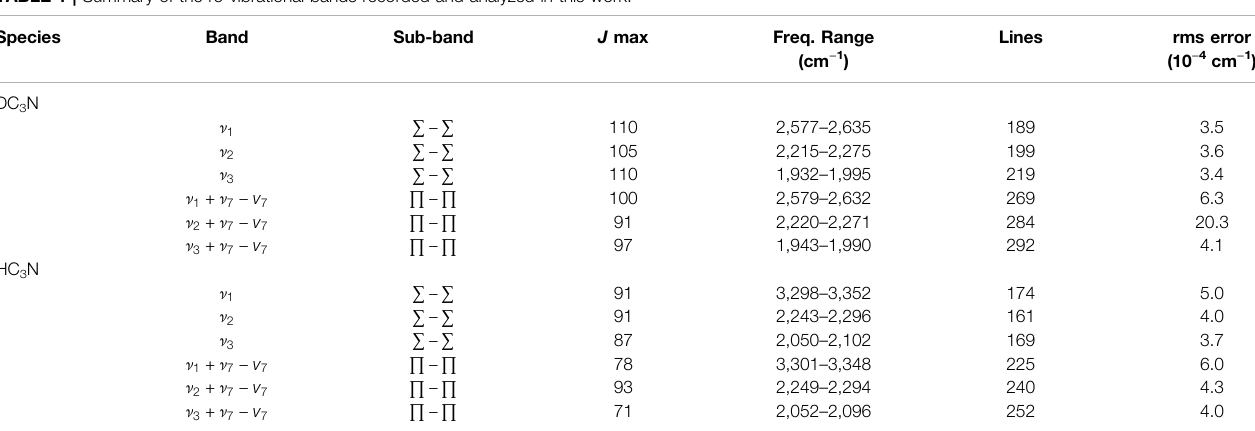
TABLE 1 | Summary of the ro-vibrational bands recorded and analyzed in this work. Species Band Sub-band J max Freq. Range